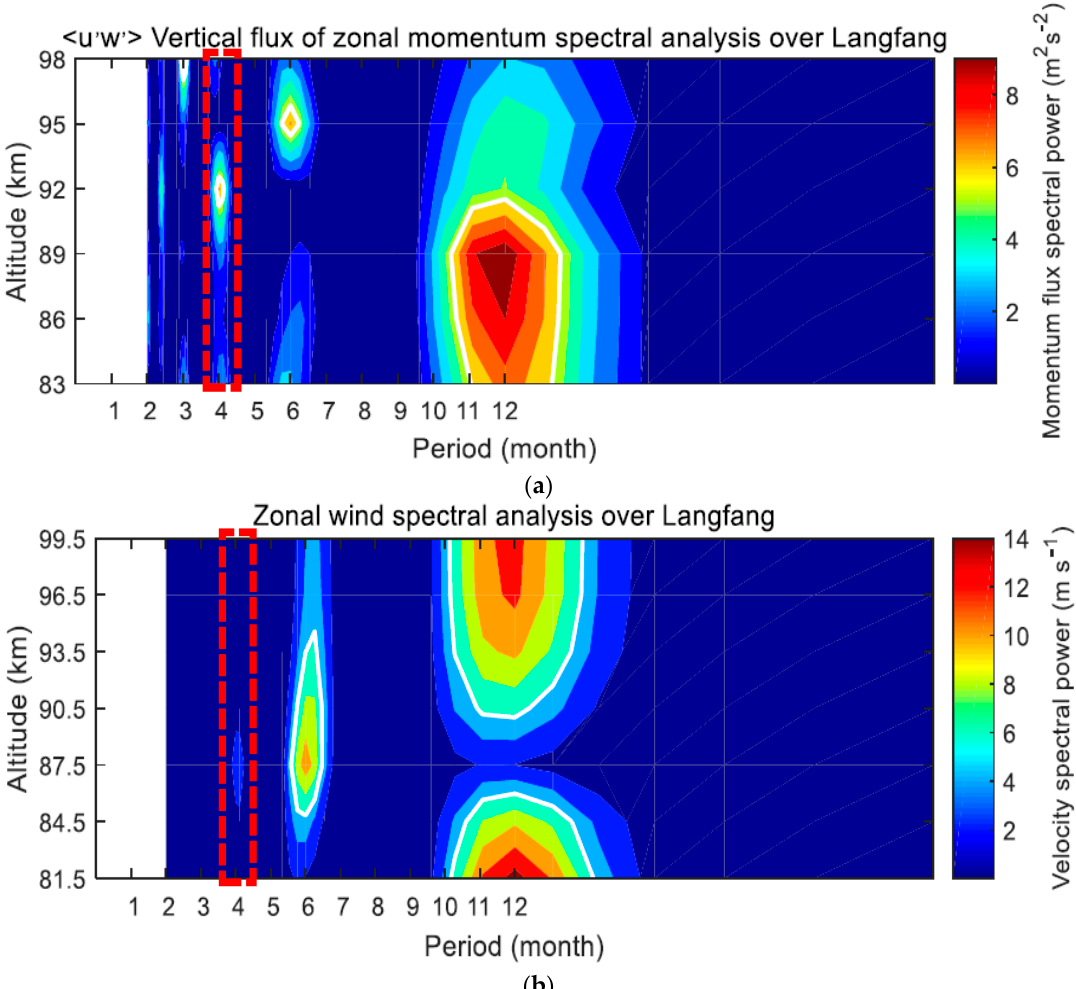
Figure 1. Height-time cross-sections of monthly averaged zonal momentum flux (upper panel) and zonal background wind (lower panel) over Langfang. Each line in the zonal momentum flux contour plot corresponds to 1 m 2 s − 2 and each contour in the zonal background wind corresponds to 5 m/s. ( a ) Vertical flux of zonal momentum over LangFang ( b ) Zonal wind over LangFang